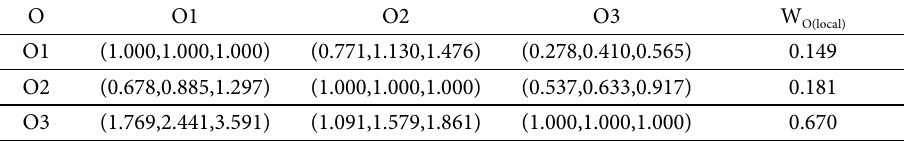
Table 10. Pair-wise comparison matrices and local weights for “O”-factor criteria